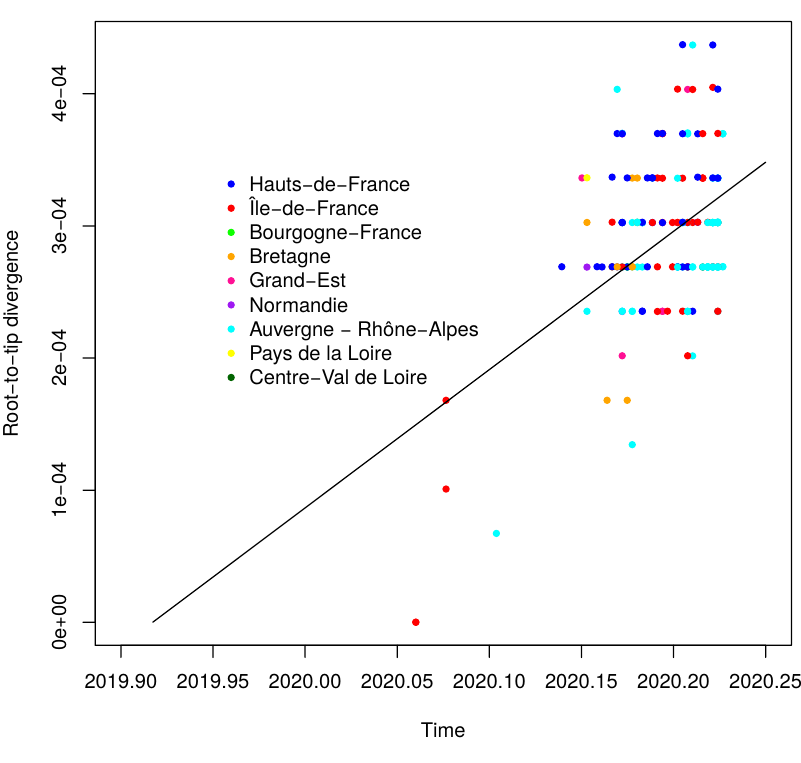
Figure S2 – Root-to-tip correlation. We analyse a phylogeny based on all 196 French sequences (i.e. not only that from the epidemic wave). The four earliest cases in Jan and early Feb were all isolated and belong to another clade than the rest of the sequences. The figure was obtained using TempEst (Rambaut, Lam, et al.,